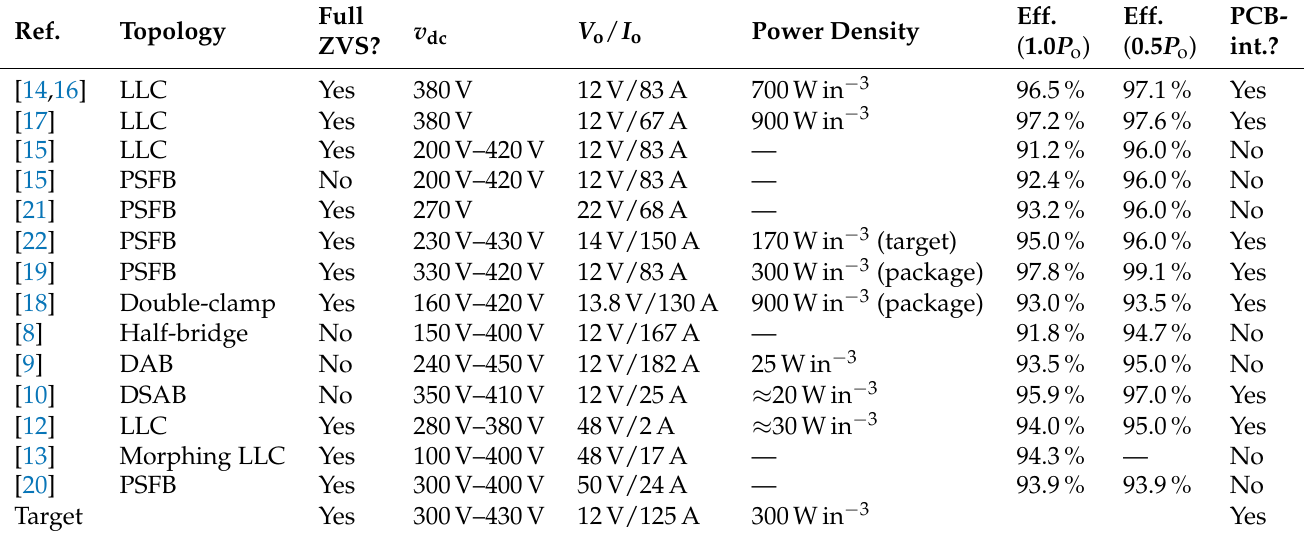
Table 2. Survey of published converters near the design specifications of the DC/DC module considered in this paper. Efficiency is given at nominal load (1.0 P o ) and 50% of nominal load (0.5 P o ).